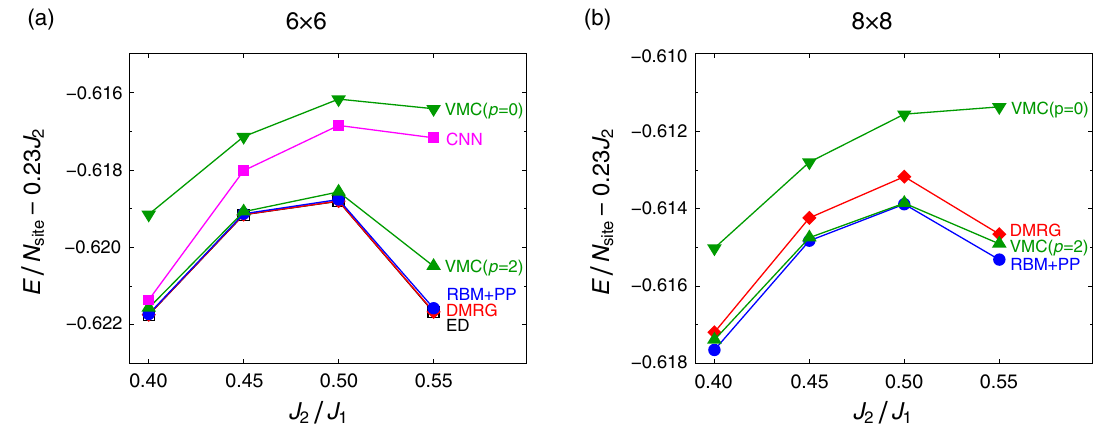
FIG. 10. Comparison of the ground-state energy for the J 1 - J 2 Heisenberg model. The comparison is made among the variational energies under the periodic boundary condition. The system sizes are (a) 6 × 6 and (b) 8 × 8 . Our RBM þ PP results are compared with those obtained by the variational Monte Carlo (VMC) method combined with the p th order Lanczos steps [23], the density-matrix renormalization group (DMRG) [with 8182 SU ð 2 Þ states] [25], the convolutional neural network (CNN) [67], and the exact diagonalization (ED) [68]. The CNN and ED results are available only for the 6 × 6 lattice.